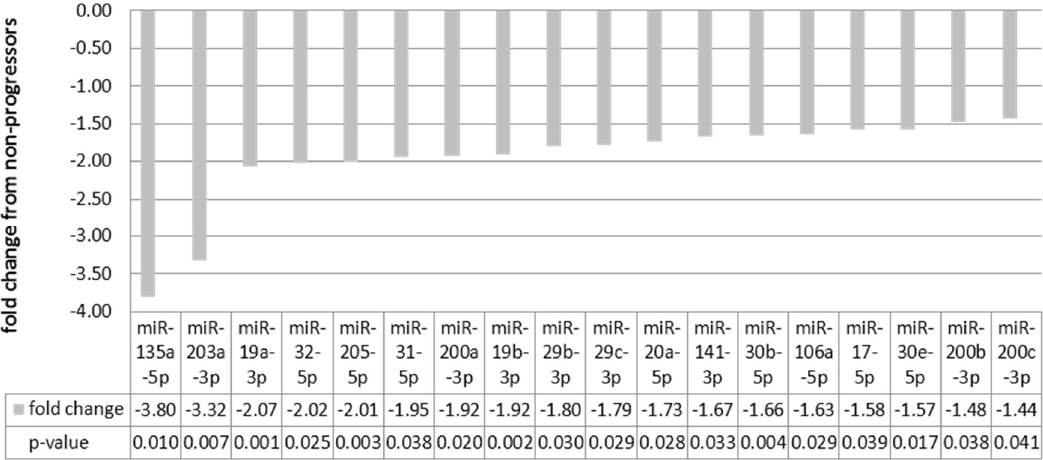
Figure 1. Relative expression within the expanded sample set: qRT-PCR results of significantly differentially expressed miRNAs. Negative fold change values indicate expression was higher in non-progressors.